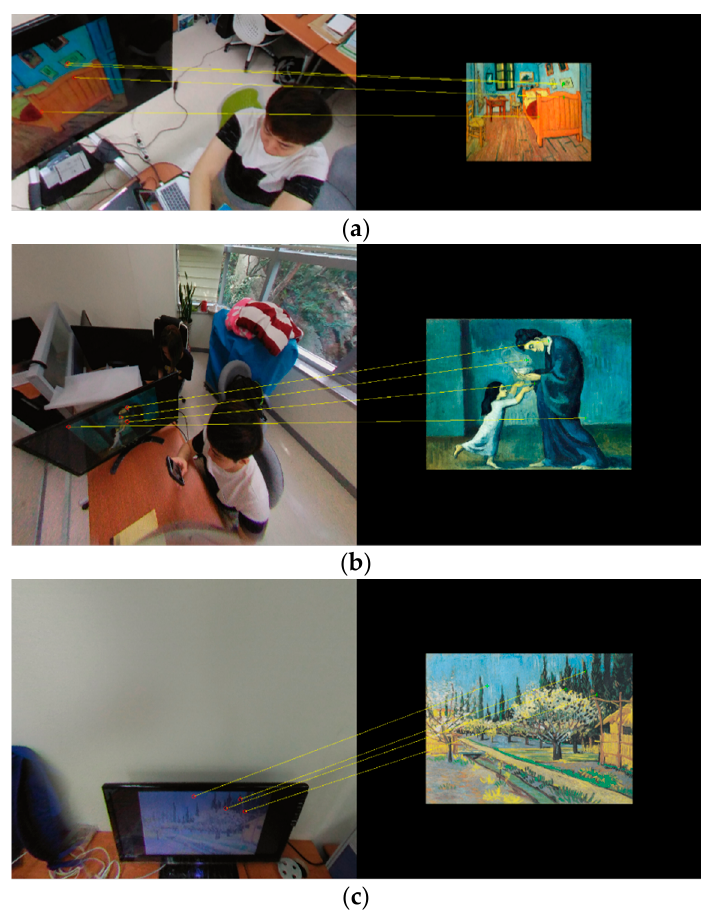
Figure 15. Projected images using the three types of polyhedrons. ( a ) A projected image using the 32-hedron; ( b ) A projected image using the octahedron; ( c ) A projected image using the dodecahedron.